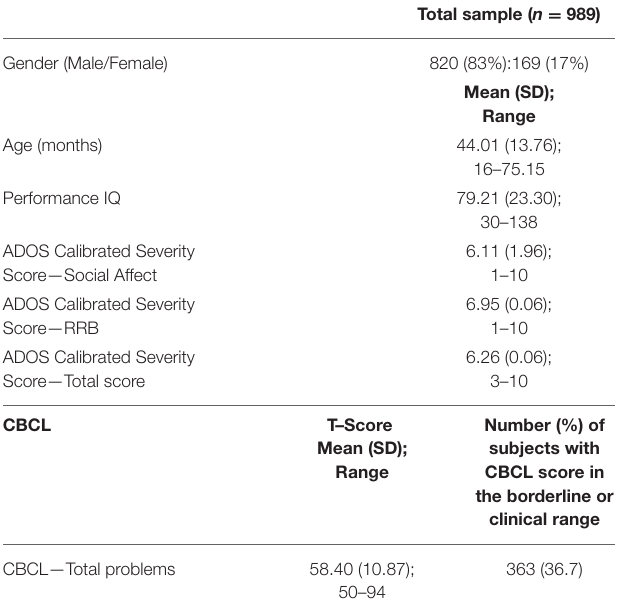
TABLE 1 | Demographic, clinical characteristics, CBCL broad–band, and DSM–IV Oriented scales scores in the total sample ( n =